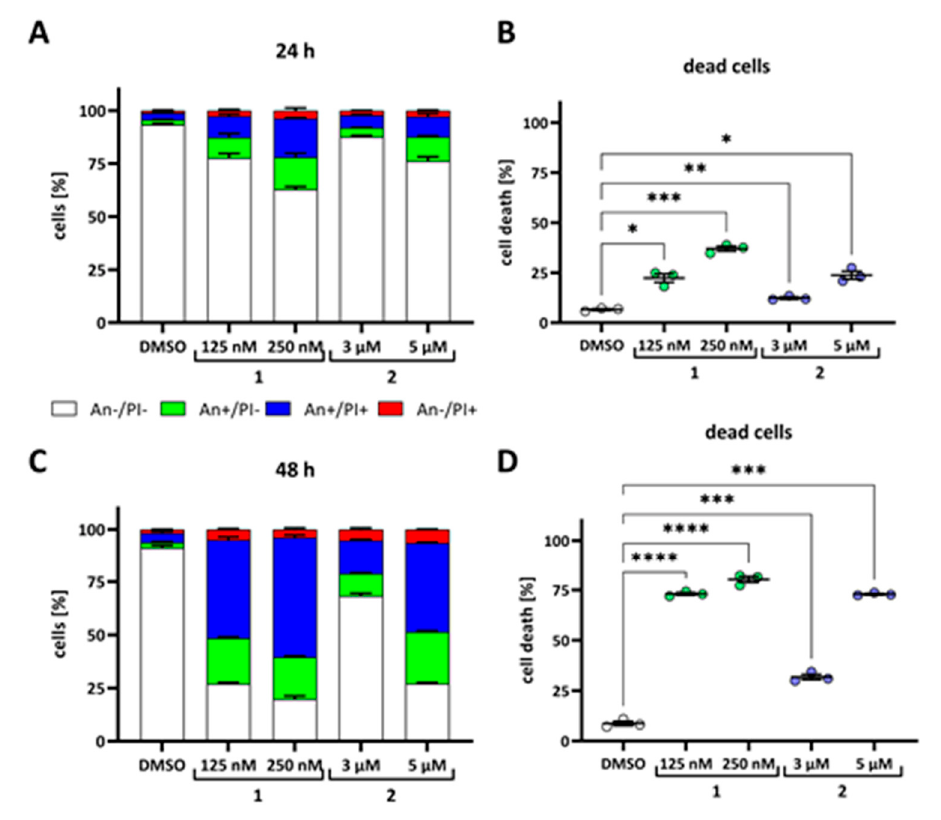
Figure 7. ( A – D ) . Annexin V/PI flow cytometry of MZ–54 cells upon treatment with 1 or 2 , mean + SEM; Brown–Forsythe ANOVA test with Dunnett’s T3 multiple comparison test (compared with DMSO control); * < 0.05; ** < 0.01; *** < 0.001; **** < 0.0001.